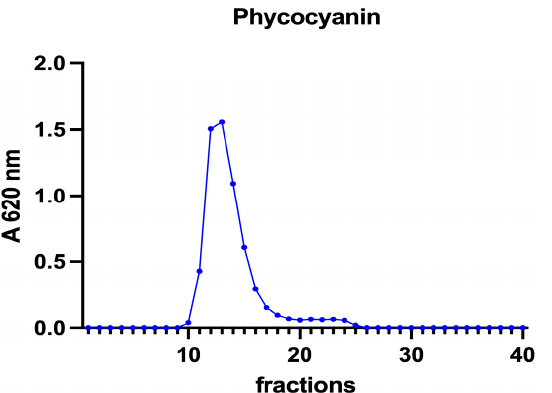
Figure 4. Chromatographic profiles of iron after SEC of extracts from algal samples. Iron concentration is expressed as µ g mL − 1 . Each chromatographic profile is the mean of two chromatographies. AP = A. platensis ; PT = P. tricornutum ; HP = H. pluvialis ; CV = C. vulgaris .